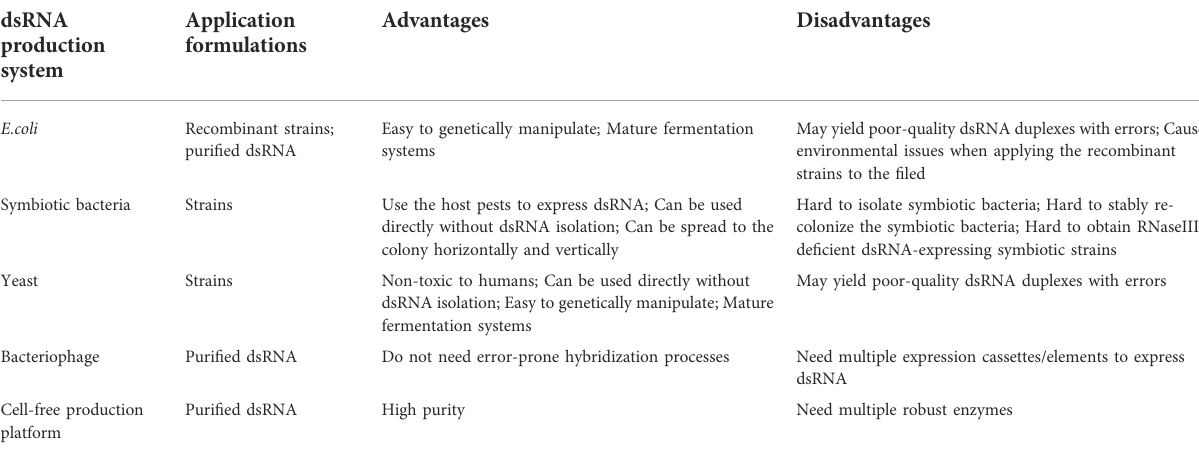
TABLE 1 The advantages and disadvantages of the dsRNA production